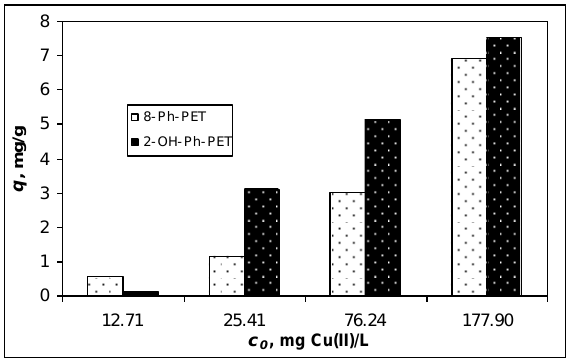
Figure 4. Adsorption capacities of 8-Ph-PET and 2-OH-Ph-PET for Cu(II) ions from aqueous media (pH = 6.5, contact time = 24 h, adsorbent dose = 8 g L −1 ).